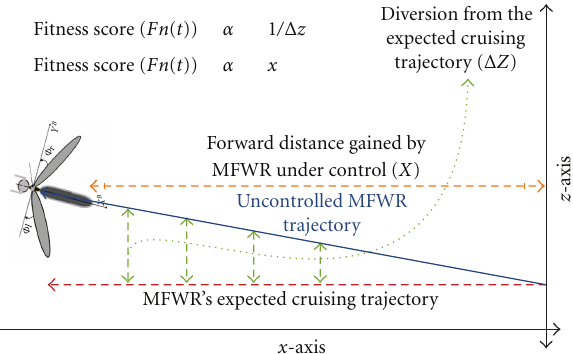
Figure 5: The figure shows the relation between the expected cruise behavior of MFWR and the fitness evaluation function employed to evolve the CTRNN-EH controllers to achieve the same behavior under control. An acceptable cruise controller has to propel the MFWR in forward direction and minimize the variation in the altitude. Thus, the fitness score employed to evolve the cruise controllers should reward any forward motion (in x -direction) and penalize any variations in altitude (in z